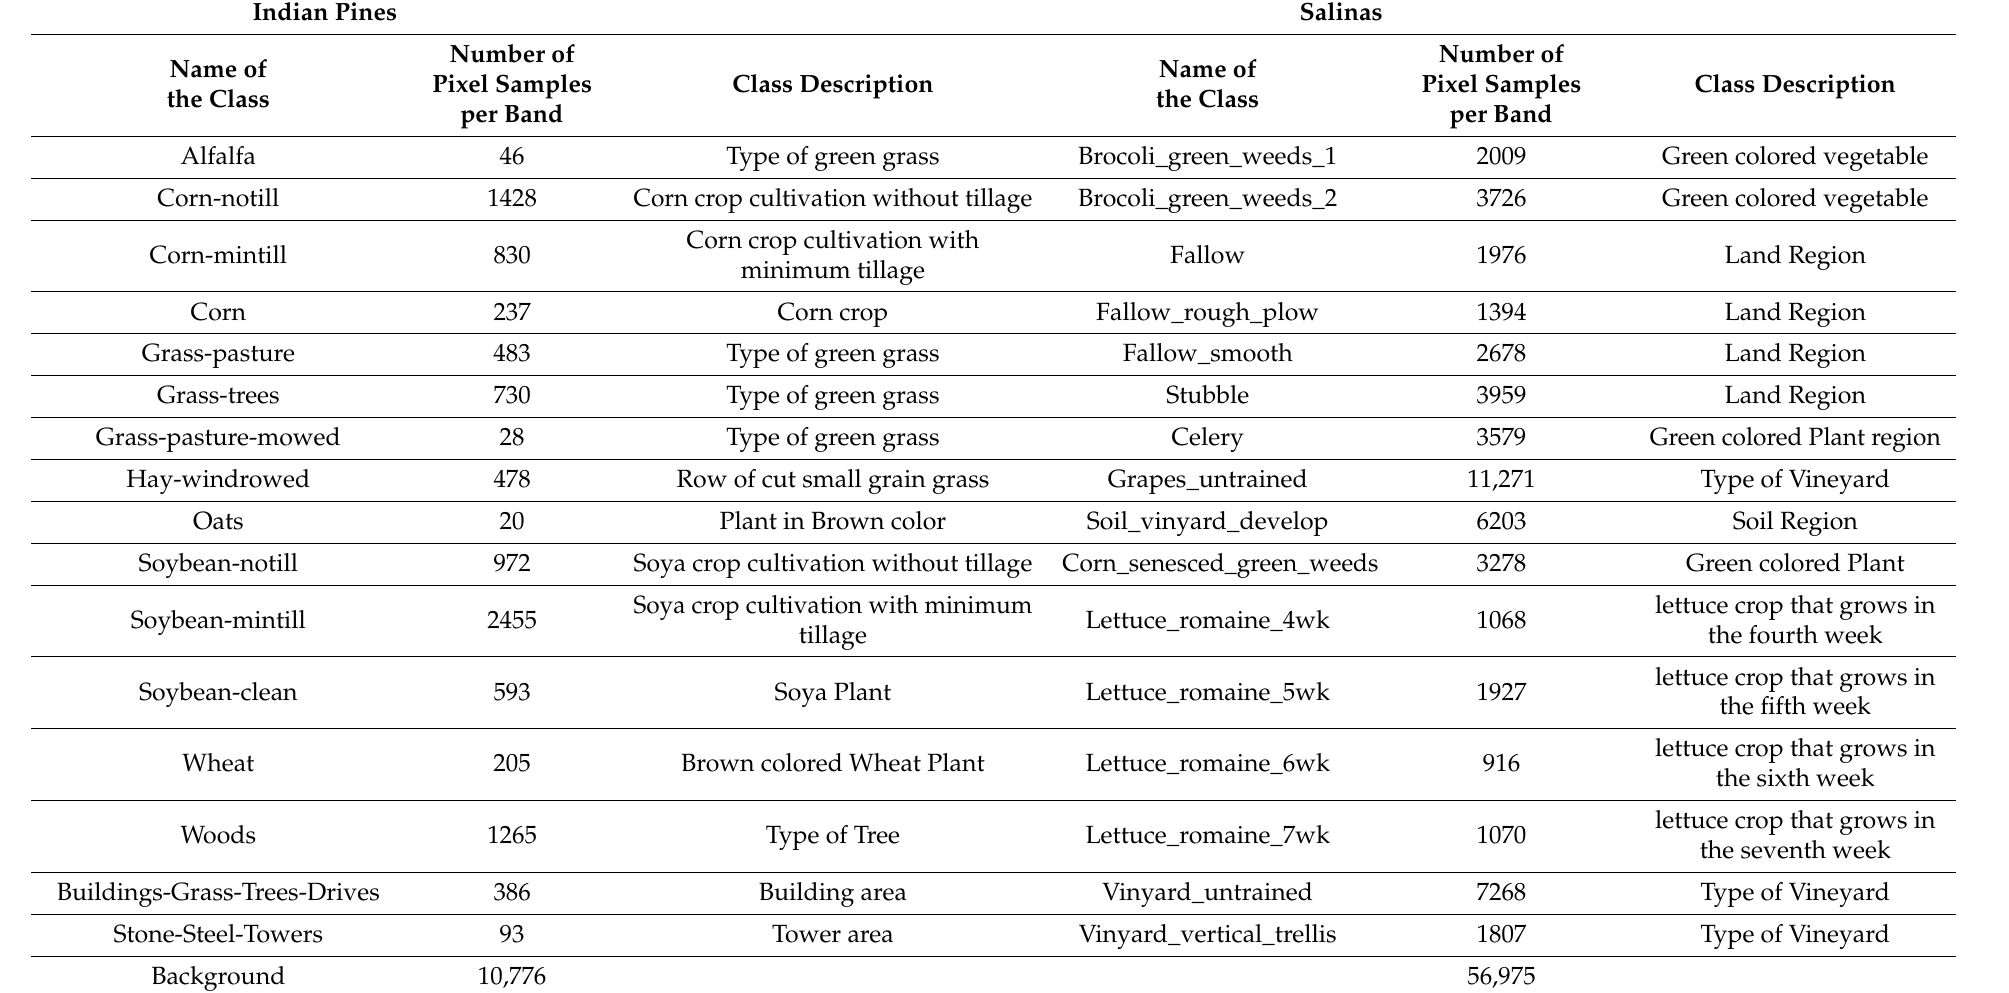
Table 1. Number of samples per class and description of each class for two standard data sets of AVIRIS